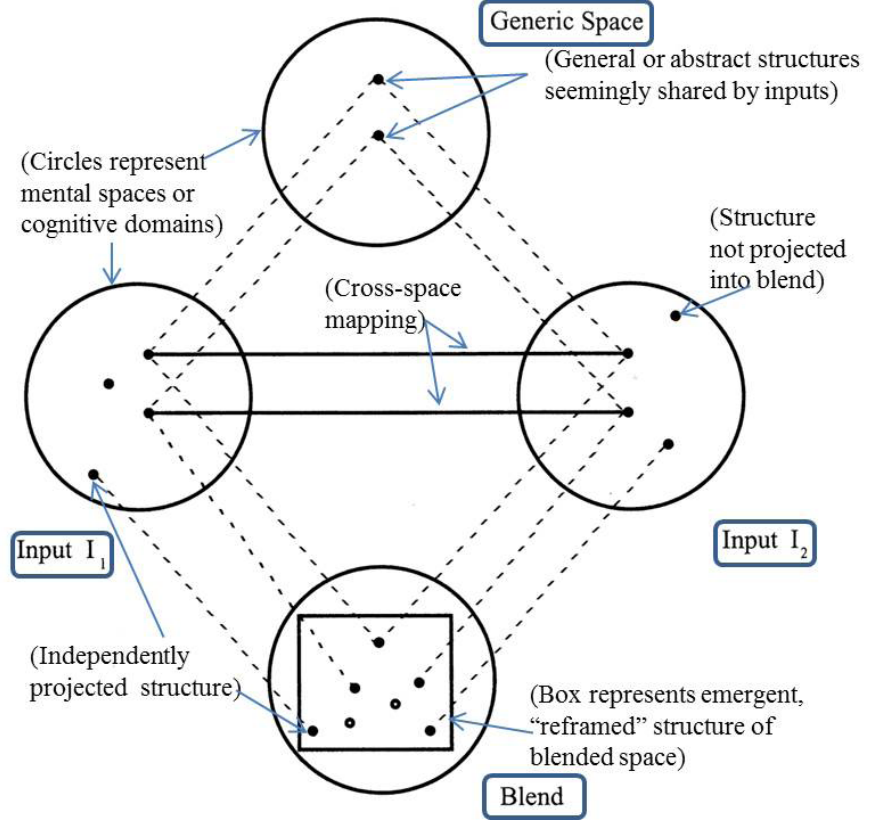
Figure 1: Conceptual Integration „Basic